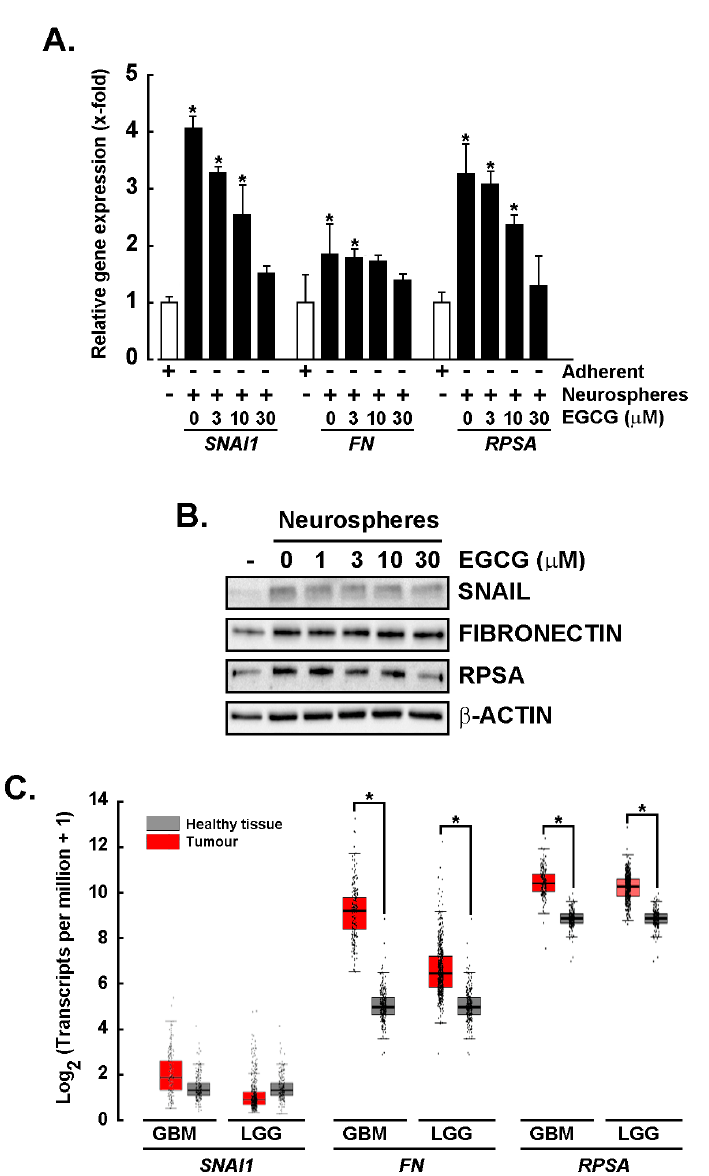
Figure 3. EGCG alters neurospheres’ epithelial-to-mesenchymal transition phenotype. ( A ) U87 glioblastoma monolayers were cultured with the Tumorsphere Medium Xf with SupplementMix to generate spheroids for 72 h in the absence or presence of increasing EGCG concentrations. Total RNA was extracted from adherent or neurospheres, and RT-qPCR analysis was used to assess the expression of EMT markers SNAIL, Fibronectin (FN), and RPSA (67 kDa Laminin Receptor). ( B ) Cell lysates were harvested from adherent, or spheroids obtained at 72 h. Western blot analysis of protein expression was performed as described in the Methods section of the described markers. Representative blots for each marker are shown from three independent experiments. ( C ) In silico analysis of SNAI1 , FN , and RPSA transcript levels was performed on clinical samples from GBM, and low-grade glioma (LGG) and compared to healthy tissue as described in the Methods section. Probability values of 0.05 were judged significant and indicated in the figure as